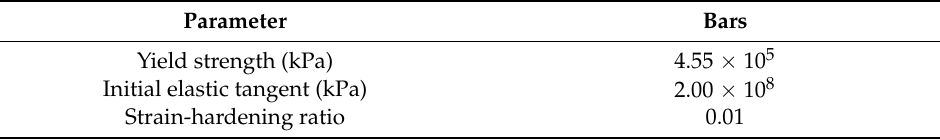
Table 4. Steel02 (Bars)